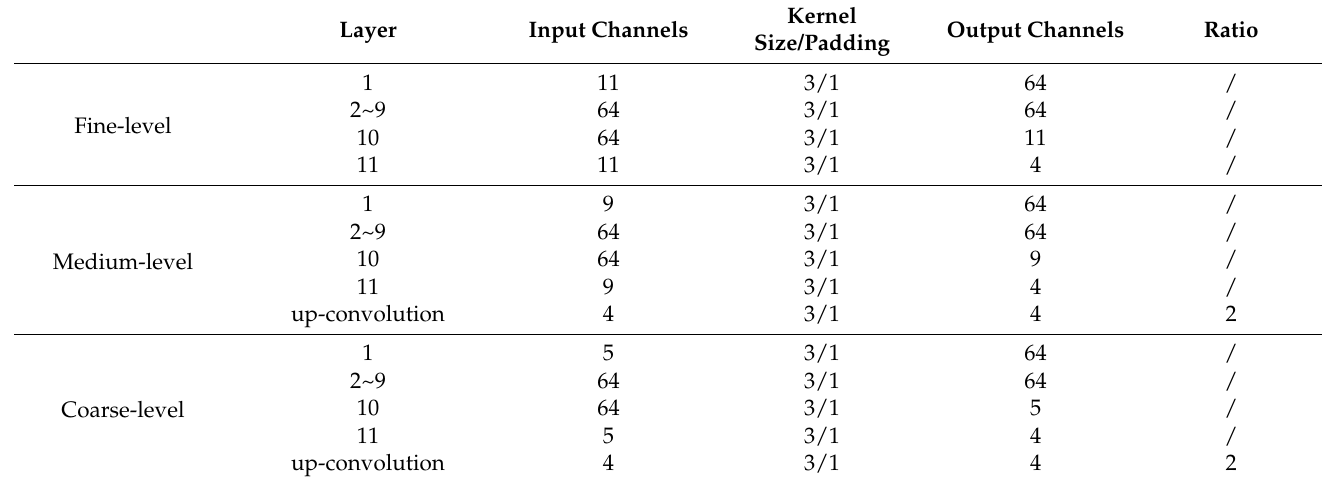
Table 1. Structural parameters of the